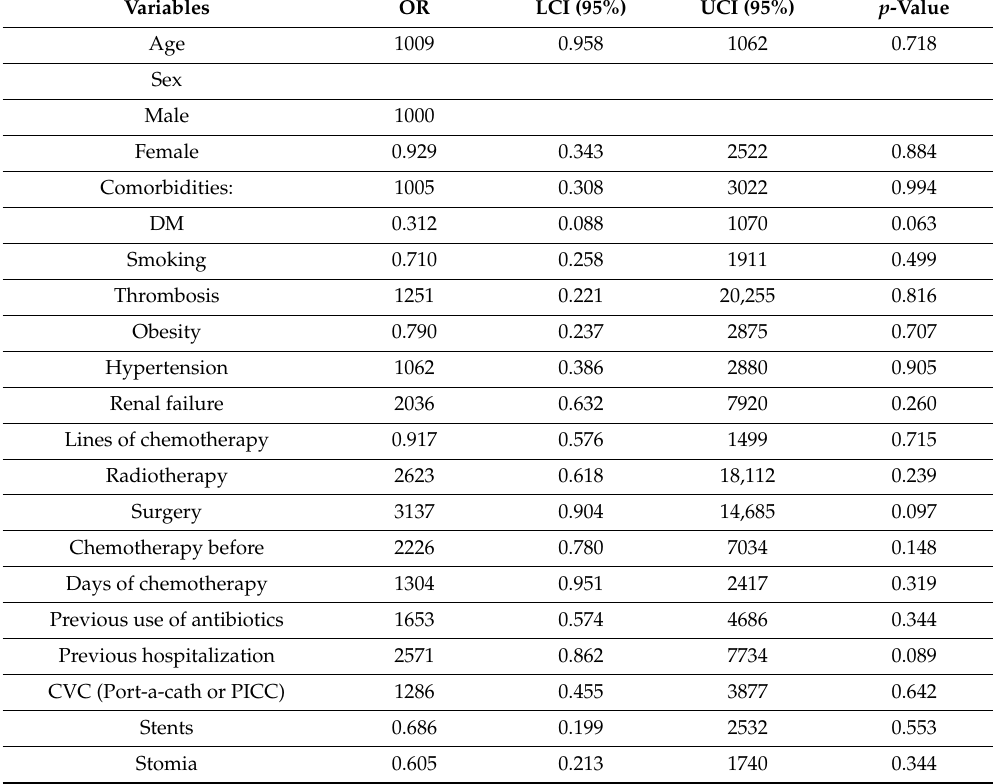
Table 3. Univariate analysis of patients’ and infection-related